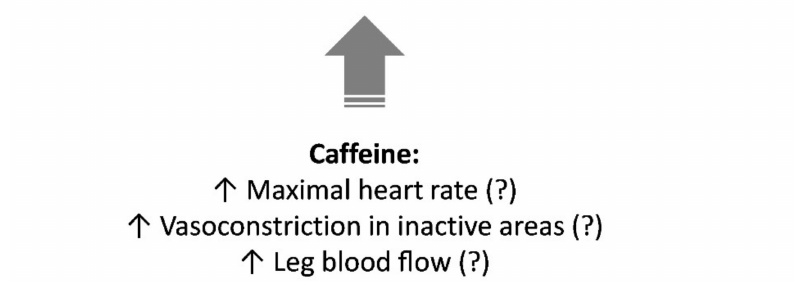
Figure 4. Main physiological events within the cardiovascular system that might contribute to fatigue during high-intensity whole-body exercise. The potential influence of caffeine on components of the cardiovascular system that might explain part of its ergogenic effect is also indicated. Although inconclusive, caffeine might increase maximal heart rate [44,45] and vasoconstriction in inactive areas [43,53], which may result in increased leg blood